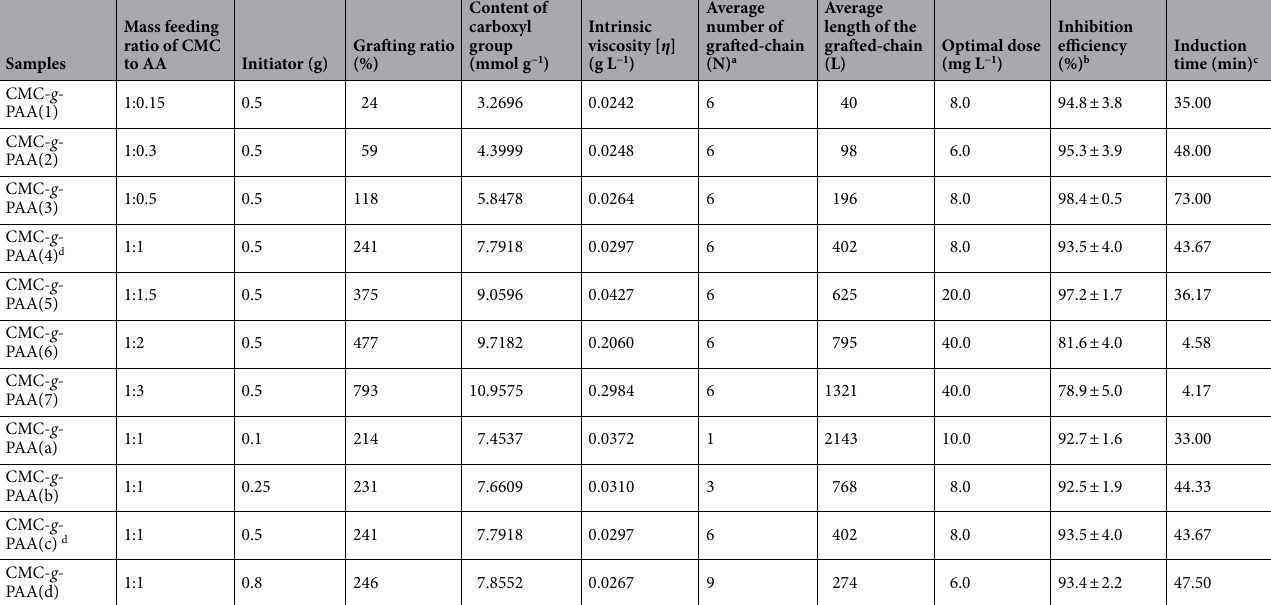
Table 2. Summary of the preparation conditions, structural parameters and the scale-inhibition performance of various CMC- g -PAA samples with different grafting ratios and grafted-chain distributions against CaCO 3 scales based on static tests and crystallization process. a The average number of grafted-chain per 1000 saccharide rings. b Scale-inhibition efficiencies of various CMC- g -PAA samples in static test, at their optimal doses. c The induction time was obtained in the presence of 1.0 mg L −1 CMC- g -PAA. d CMC- g -PAA(4) and CMC- g -PAA(c) are the same